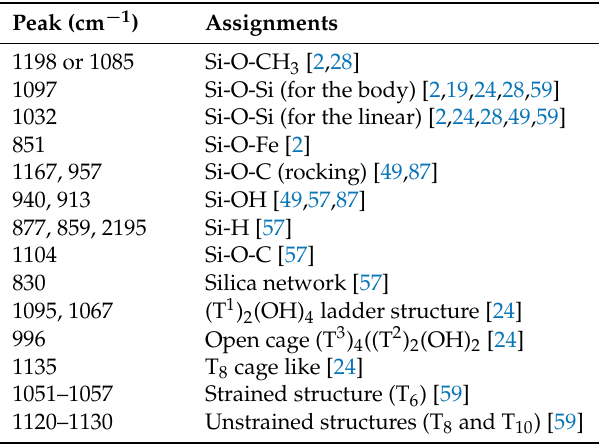
Table 6. Assignment of the FTIR peaks for silanes.